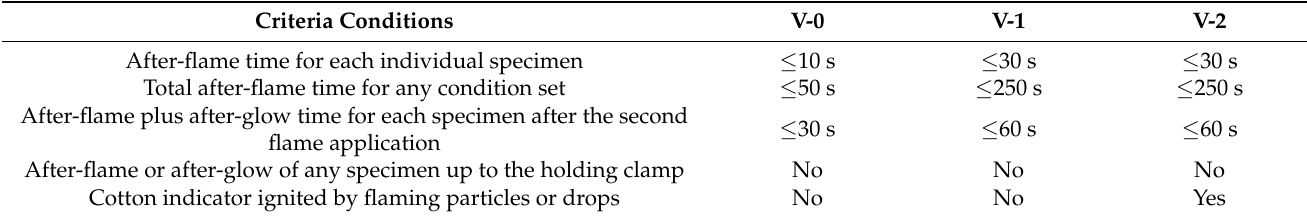
Table 2. Classifications of the burning behavior according to KS M ISO